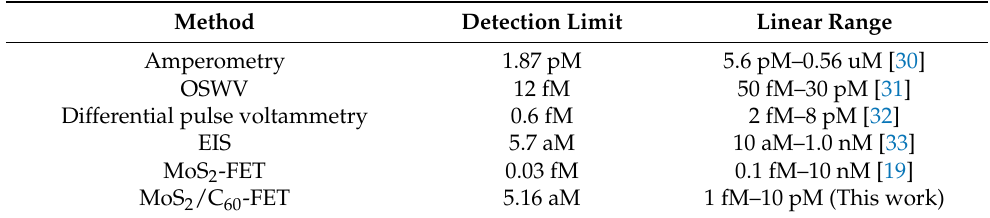
Table 4. Comparison of the analytical performance of microRNA-155 detection